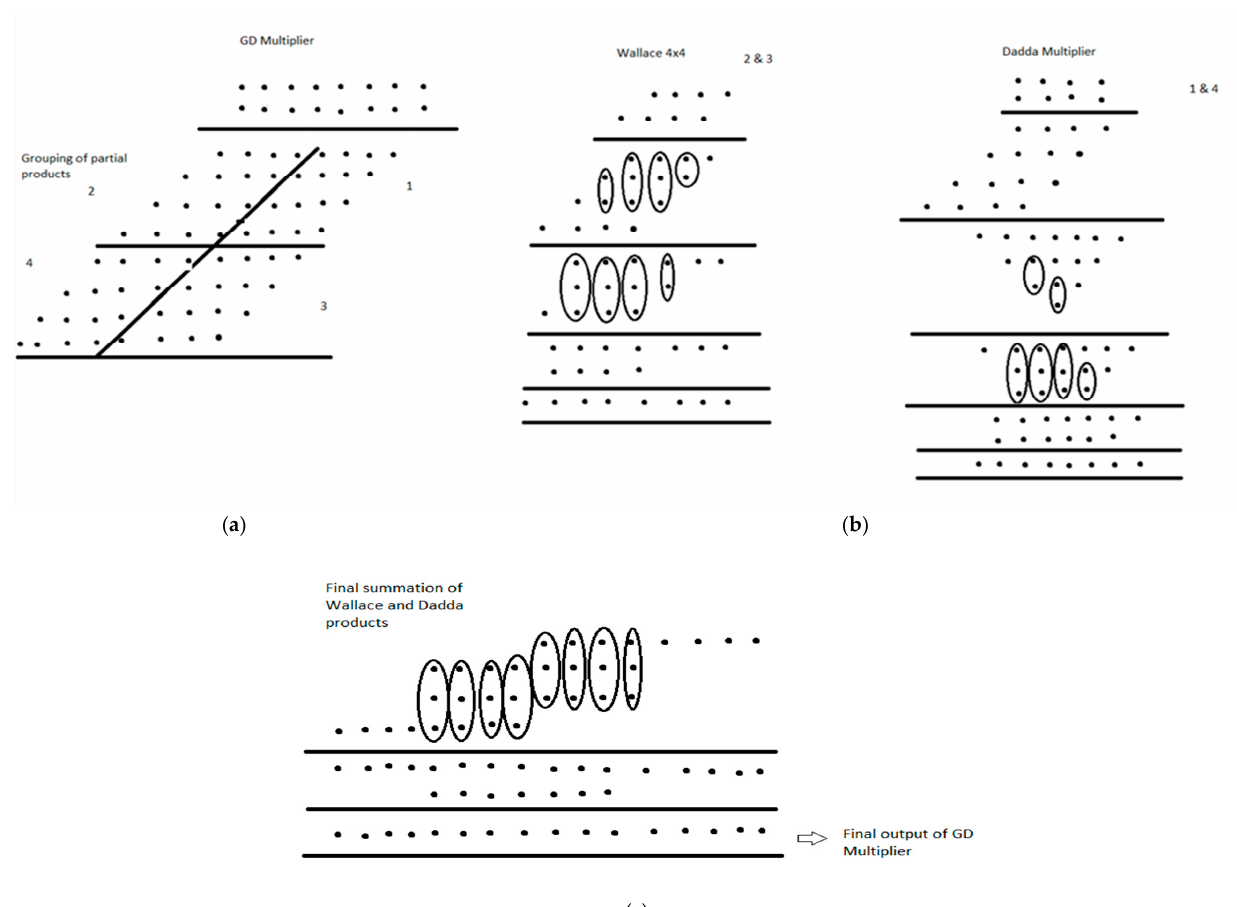
Figure 7. Working principle of 8 × 8 GD multiplier: ( a ) Grouping of products (into 4 groups) performed in 8 × 8 GD multiplier; ( b ) Flow of 4 × 4 Wallace multiplier used during decomposition (for groups 2 and 3) and Flow of 4 × 4 Dadda multiplier used during decomposition (for groups 1 and 4); ( c ) Terminal-layer processing using